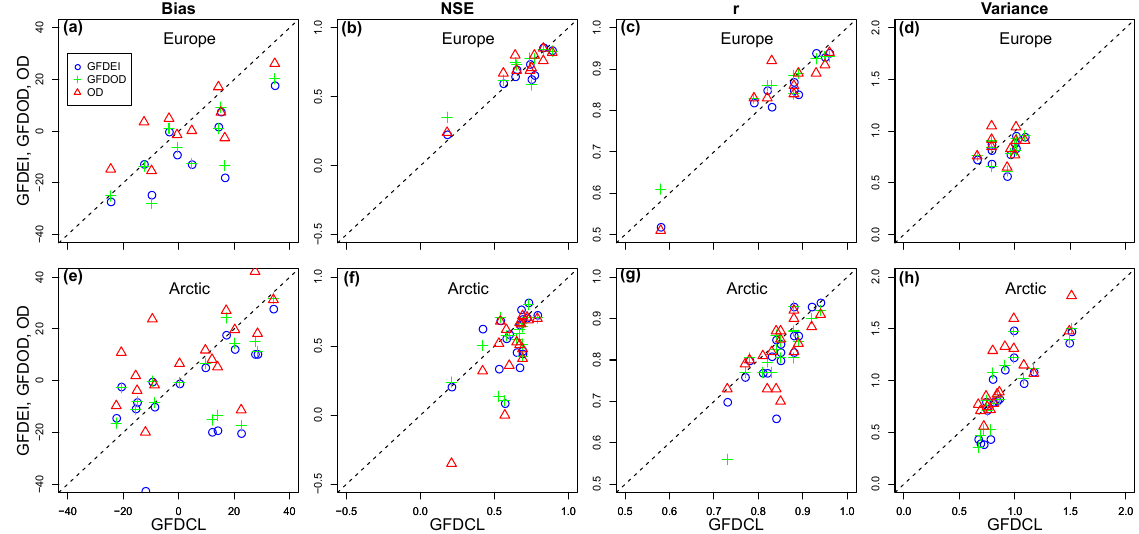
Figure 7. River discharge model performance measures: bias (relative volume error in %), Nash–Sutcliffe efficiency (NSE), Pearson corre- lation ( r ), and ratio of simulated and observed variance for a selection of grid points in (a–d) Europe and (e–h) the Arctic. The performance of GFDEI, GFDOD and OD ( y axis) is compared to GFDCL ( x axis) in scatter